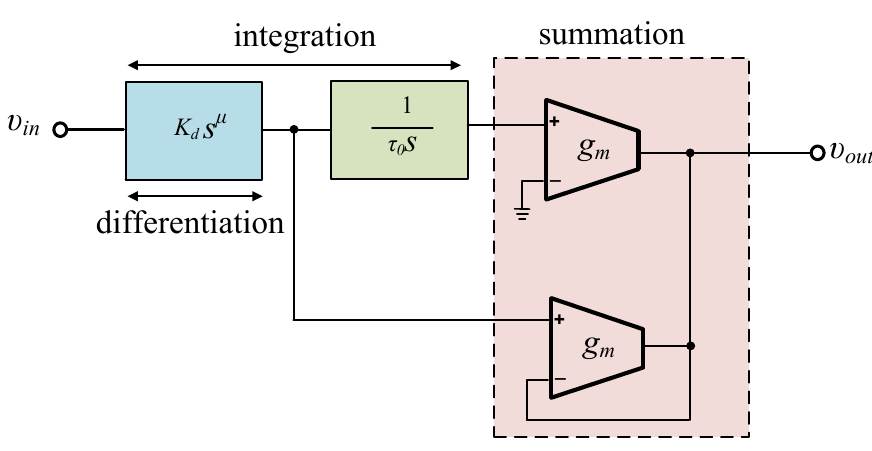
Figure 3. Proposed functional block diagram of the controller in order to reduce the active component